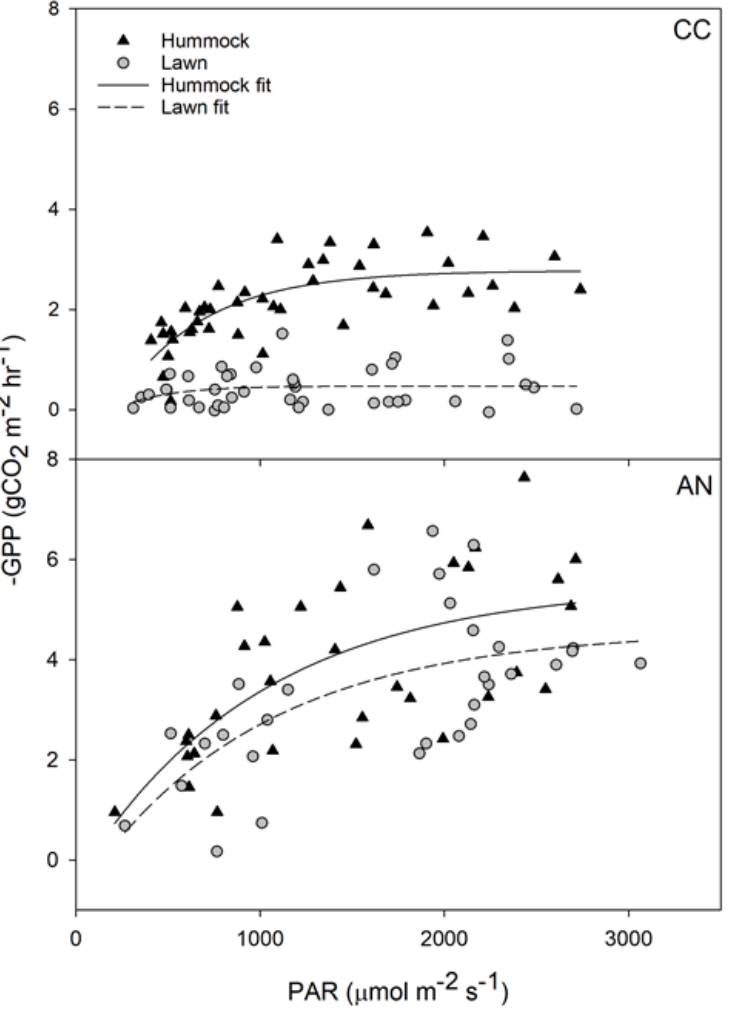
Figure 7. Light response curves, gross primary production (GPP; g CO active radiation (PAR; µmol m -2 s -1 ) by microtopography (hummock and lawn) for Cayambe Coca (CC) and Antisana (AN). The inverse sign for GPP was used in these light response curves. Note that AN values only included collars with 100 % vegetation cover. The equation fitted is exponential rise to the maximum, single, 3 parameter: f = y0 + a(1 -